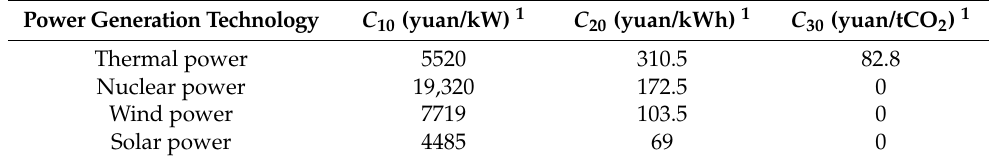
Table 1. Some cost parameters of the initial